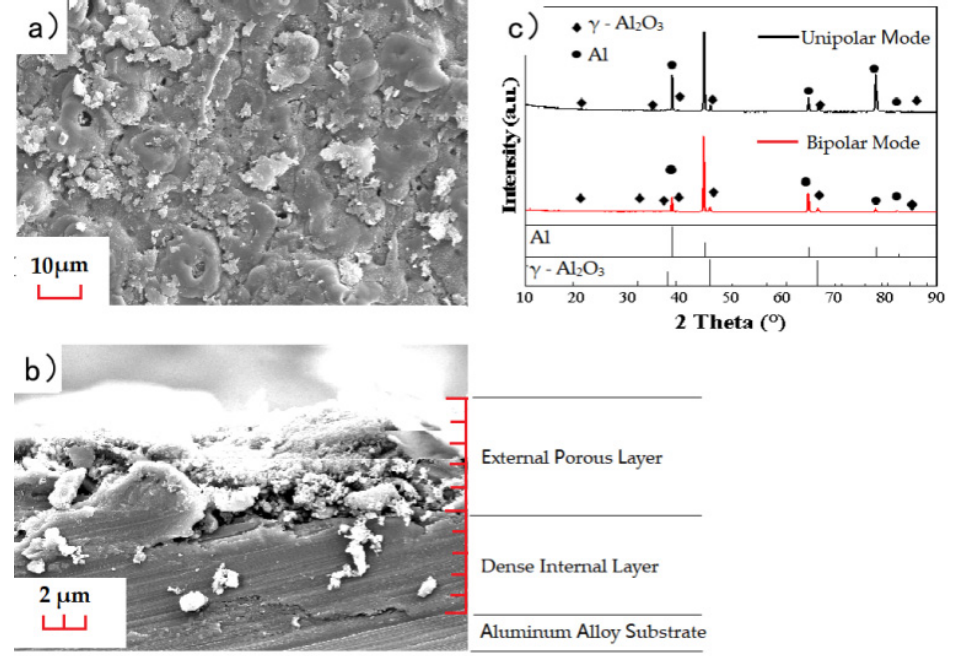
Figure 2. Composition and micromorphology of the MAO layer. ( a ) the MAO layer surface zoom in 200×; ( b ) the MAO layer cross section zoomed in at 1000×; and ( c ) the XRD pattern of the layer under unidirectional pulse and bidirectional pulse conditions.